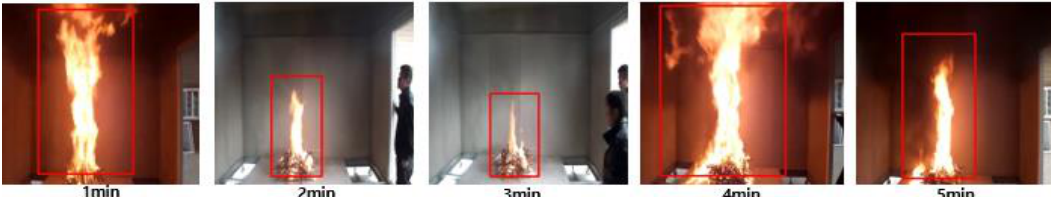
Figure 17. Sample still shots of decreasing followed by increasing flame video clip.